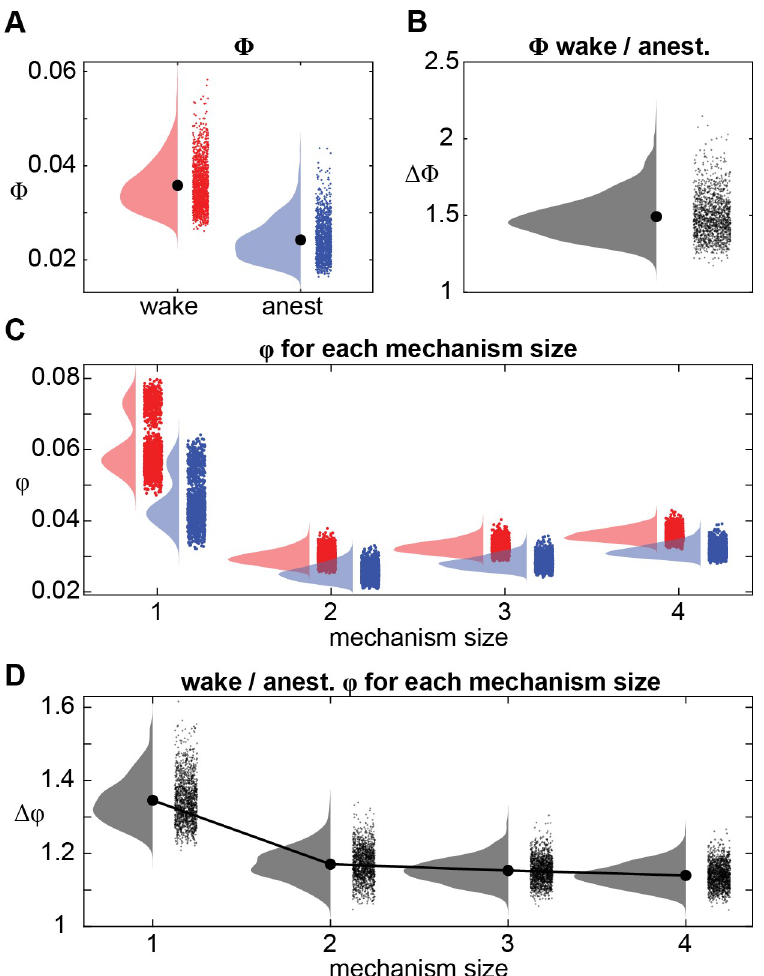
Fig 4. Effect of anesthesia on system-level integrated information ( F ) and the integrated information structure (IIS: a set of φ values). ( A ) F values during wakefulness (red) and anesthesia (blue) for each of 1365 channel sets, averaged across flies. ( B ) Ratio of F (wakeful / anesthetized), for all channel sets, averaged across flies. ( C ) φ values from the IIS for each mechanism size, for wake (red) and anesthesia (blue). We show the average value for each of 1365 channel sets averaged across flies for each mechanism size. ( D ) Ratio of wakeful φ to anesthetized φ (averaged across flies) for each mechanism size.